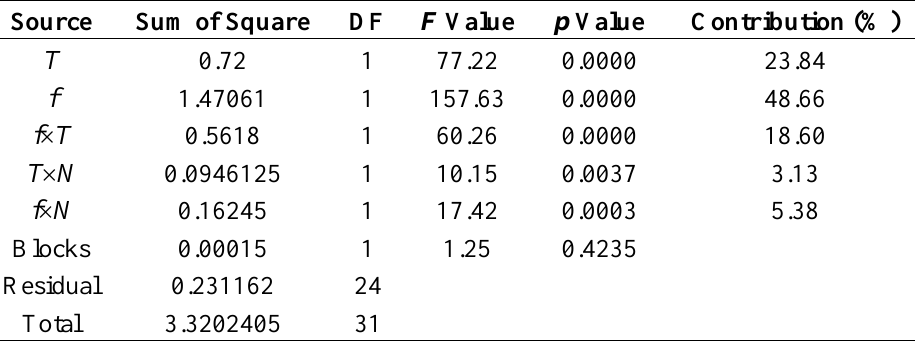
Table 4. ANOVA analysis of Ra .